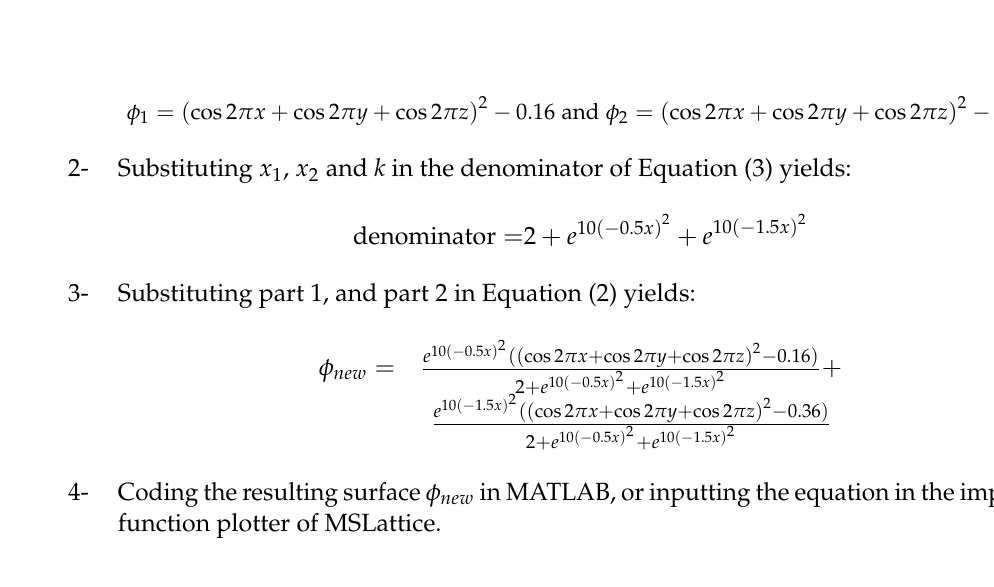
Substituting x 1 , x 2 and k in the denominator of Equation (3) yields: